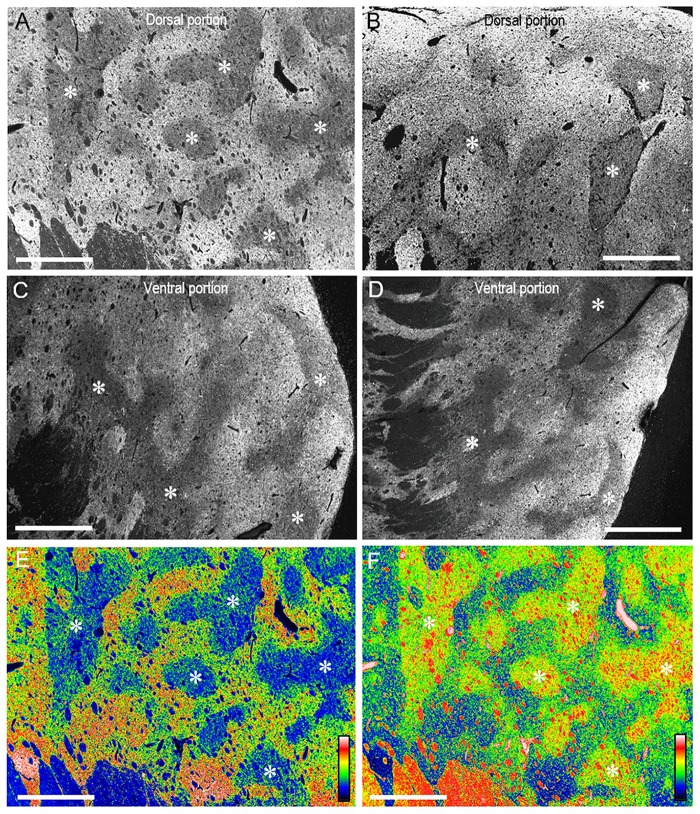
Mosaic pattern of TH-immunostaining in the rostral putamen of the human brains. (A–D) Photomicrographs of the dark-field images taken from the dorsal (A,B) and ventral portions (C,D) of the rostral putamen stained with DAB for TH. Asterisks indicate examples of striatal subfields with sparse TH labeling. (E,F) Graded color-converted representations of dark-field (E) and bright-field (F) images of the striatal area stained with DAB for TH, which is shown in (A). A standard pseudocolor scale from blue (lowest level) through green, yellow, red, and white (highest level) was used. Asterisks indicate examples of corresponding zones poor in TH-labeling. Scale bars: 2 mm.